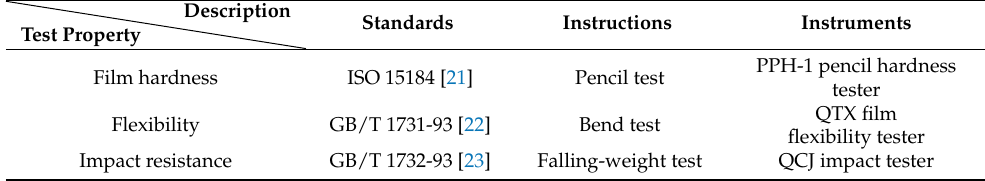
Table 1. Test standards and instructions of the physical properties of the